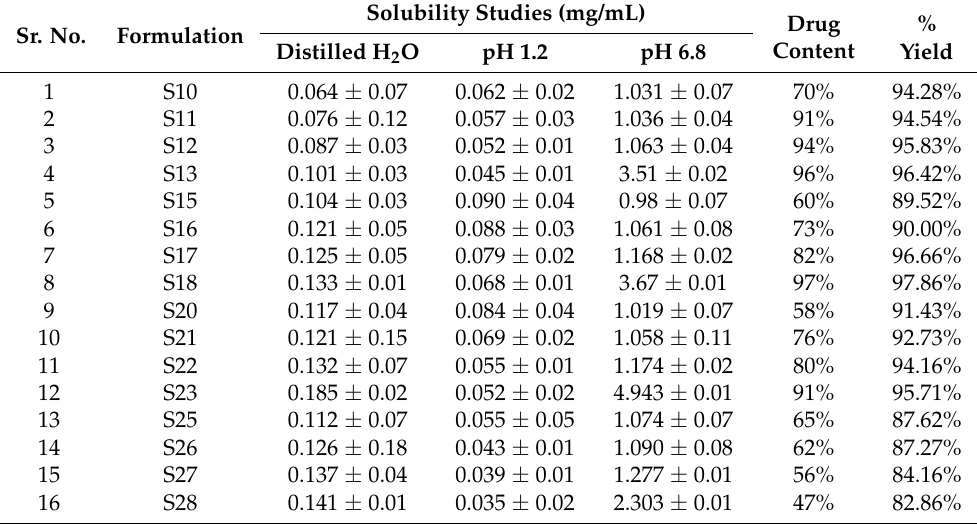
Table 5. Solubility, percentage drug content, and percentage yield of ternary formulations. Sr. No.